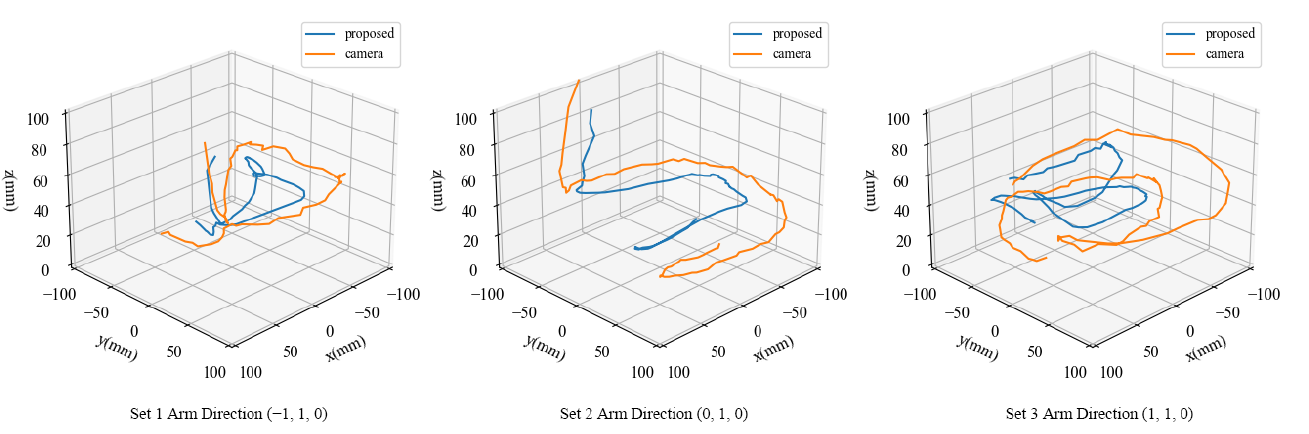
Figure 12. Comparison of hand trajectories between the sensor and depth camera. The blue and orange lines represent the sensor and the camera,